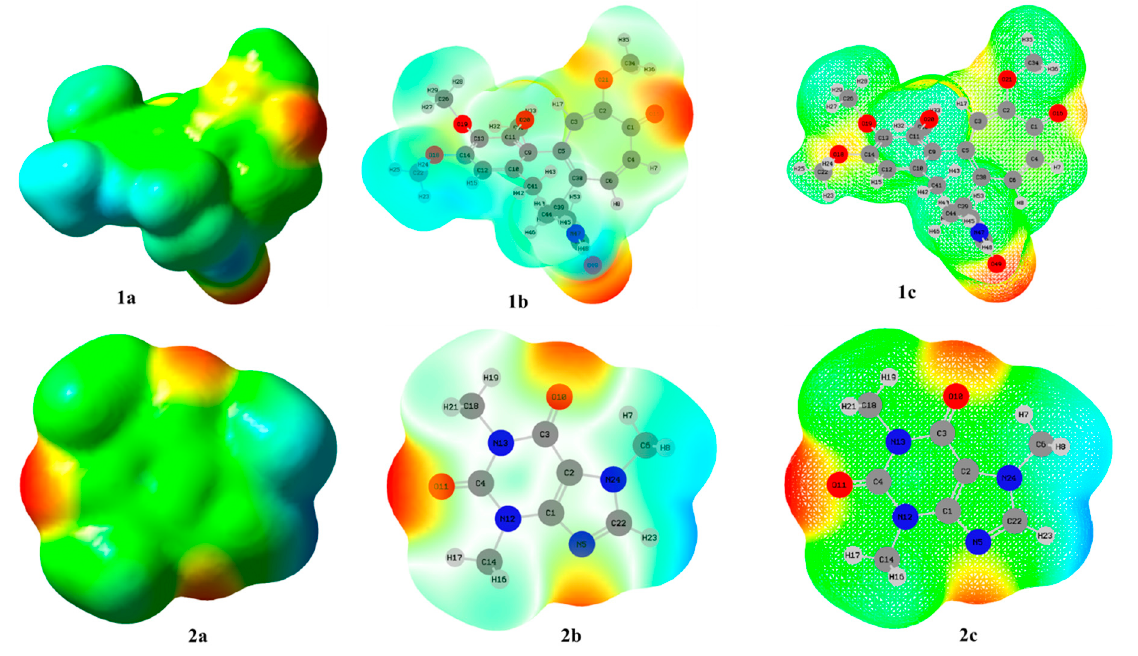
Figure 10. Molecular electrostatic potential of the purified compounds with different behaviors; ( a ) Total density, ( b ) Transparent, ( c ) Mesh format.